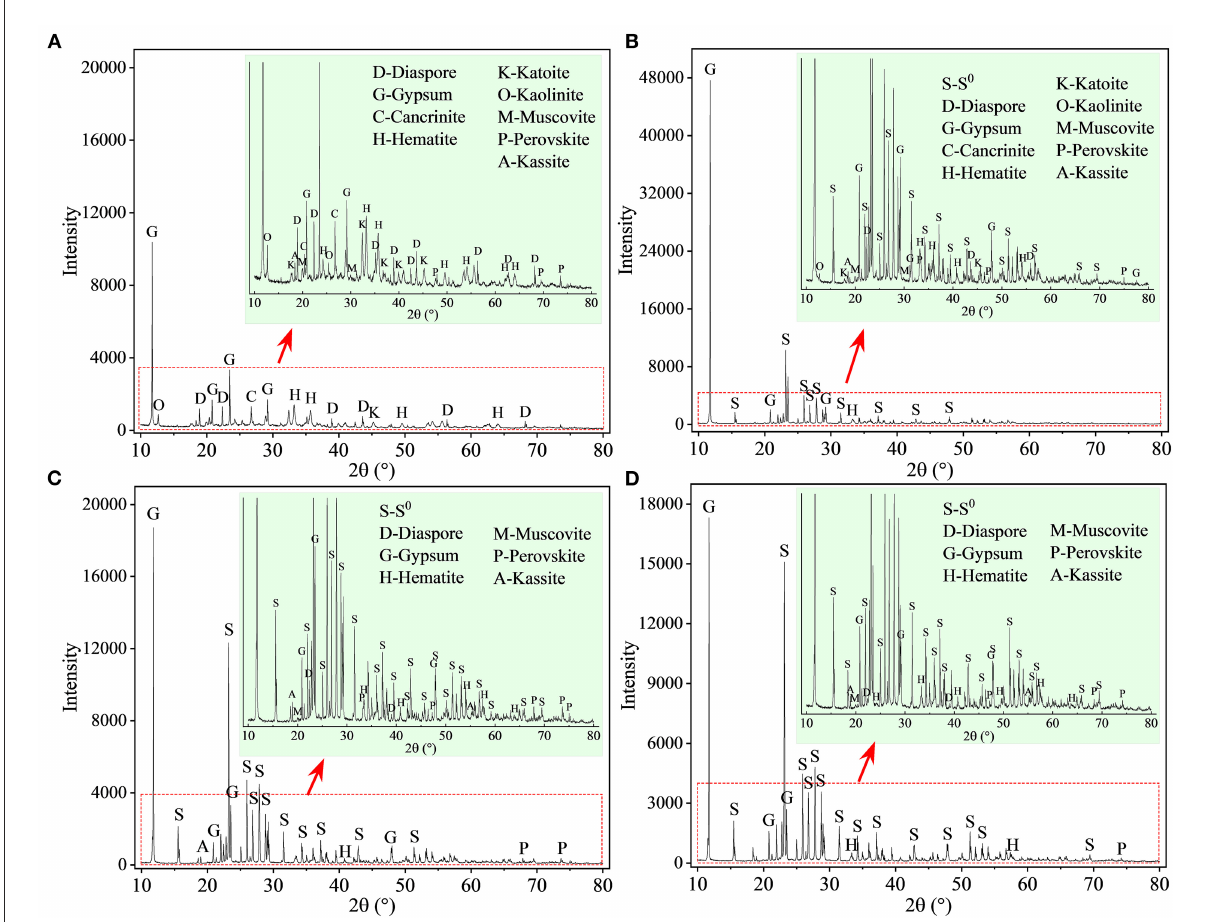
FIGURE5 XRD patterns of solid residues after bioleaching of metals from RM. Bioleaching was conducted for 27 days in shake flasks with the S 0 /RM mass ratio of (A) 0:1, (B) 1:1, (C) 2:1, and (D) 3:1. The zoom image represents the enlarged area delineated by the red rectangle.